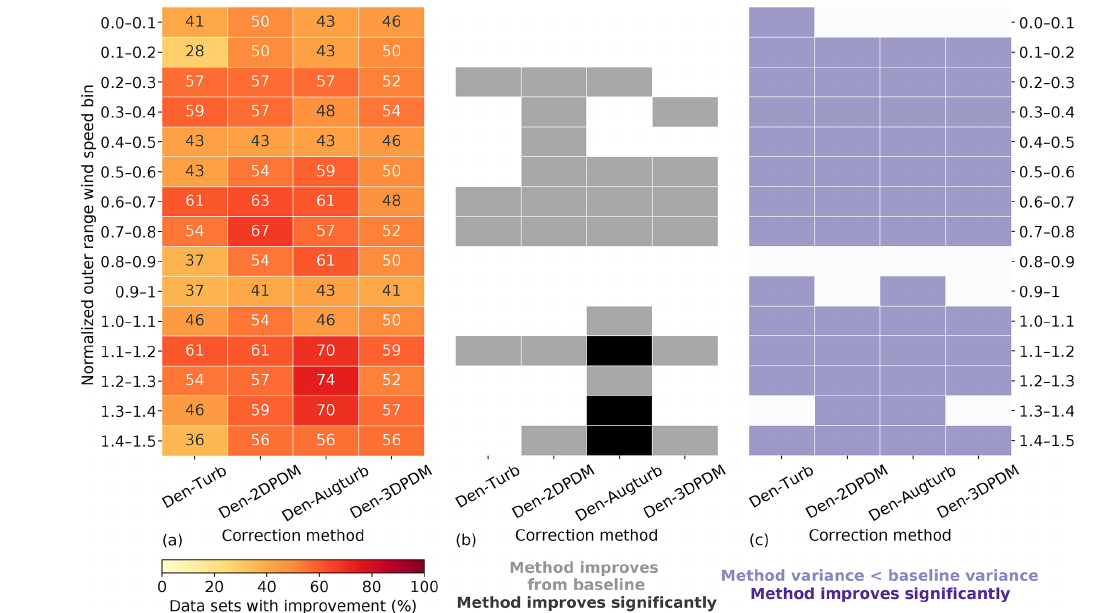
Figure D2. As in Fig. D1, but for normalized wind speed bins in the outer